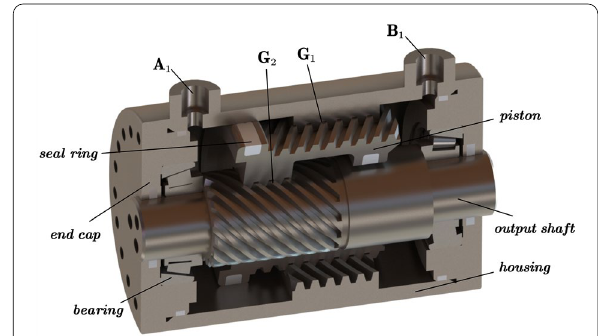
Figure 1 Structural diagram of helical hydraulic rotary actuator